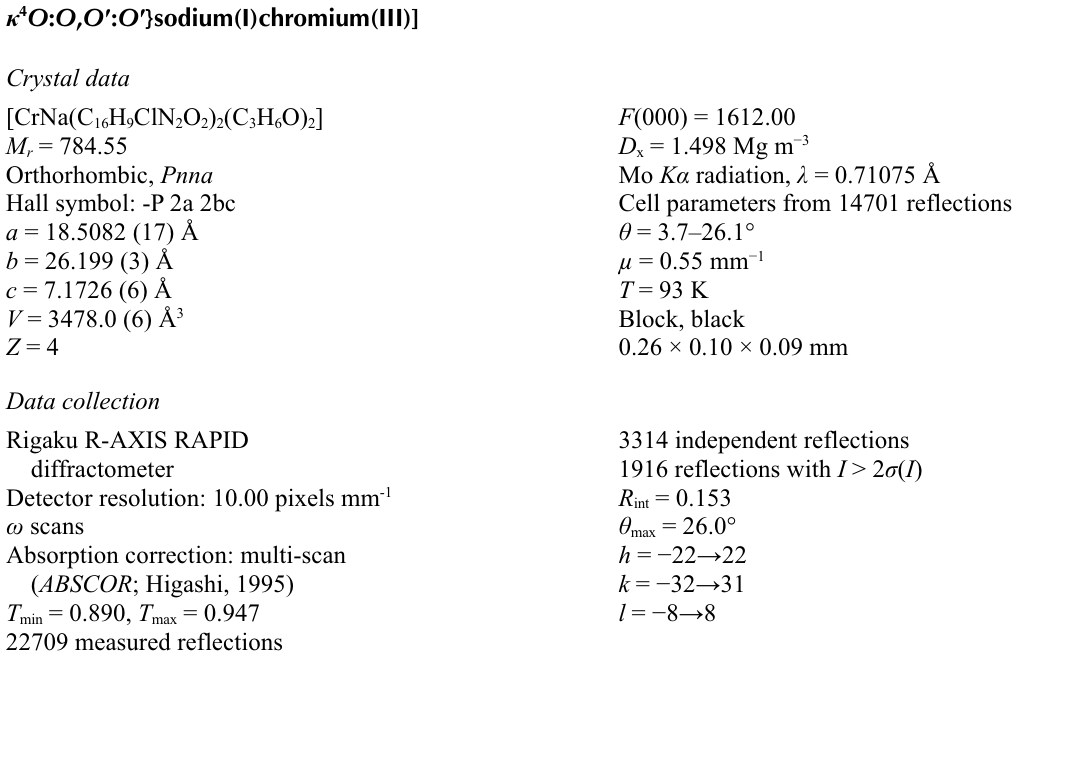
Figure 2 Polymeric structure of the title compound along the c axis. Poly[bis(acetone)bis{ µ -1-[(5-chloro-2-oxidophenyl)diazenyl]-2- 3